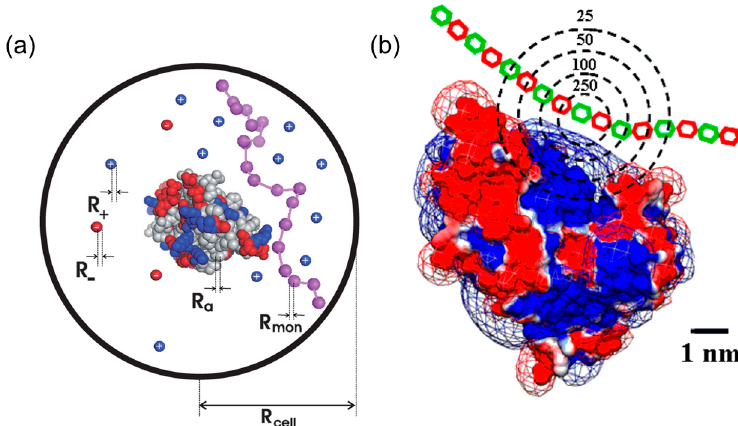
Figure 1. Schematic representation of different protein–PE binding mechanisms. For charge regulation theory ( a ), polyeletrolytes, represented by purple chain, and proteins with positive (blue) and negative (red) residues are surrounded by counter ions within a spherical space denoted as a cell. For charge anisotrpy theory ( b ), proteins with positive (blue) and negative (red) patches as visualized by Delphi interacts with polyelectrolytes with different charged units (red and green). Figure 1 was taken from the works of [21,30].